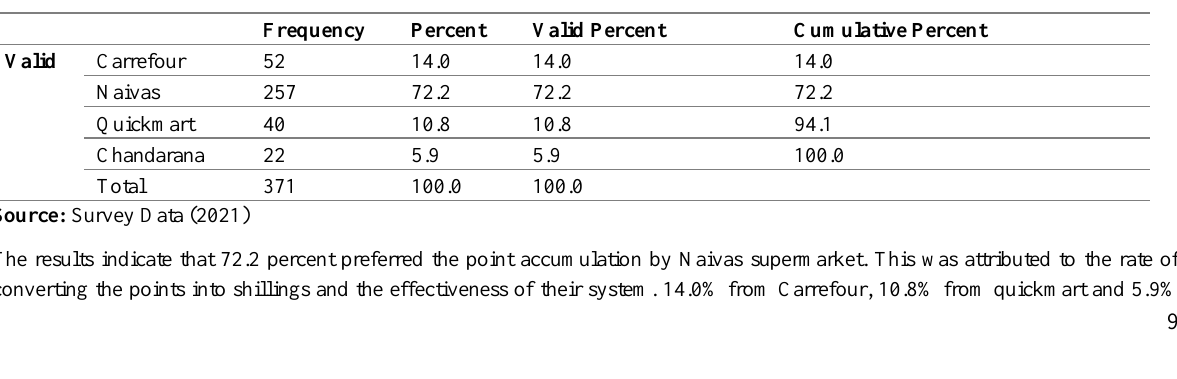
Table 7: Points Accumulation by